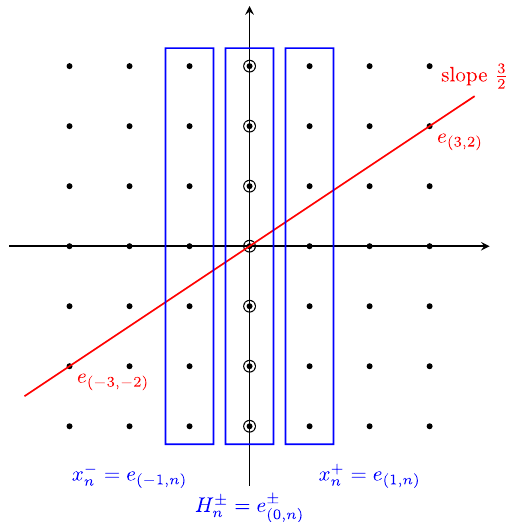
Fig. 1 The grading lattice of eDIM algebra. The generator at ver- tex ( n , m ) is denoted by e ( n , m ) . The generating currents are framed (cid:9) (cid:9) e ( ± 1 , n ) z − n and ψ ± ( z ) = exp H ± n z − n = in blue, x ± ( z ) = (cid:9) n ∈ Z n (cid:14)= 0 e ± ( z − n . Notice that the vertices on the vertical line unlike exp n (cid:14)= 0 0 , n ) theotherscontain two generators e ± ( .Theredlinedenotesanexample 0 , n ) of a Heisenberg subalgebra of slope 3